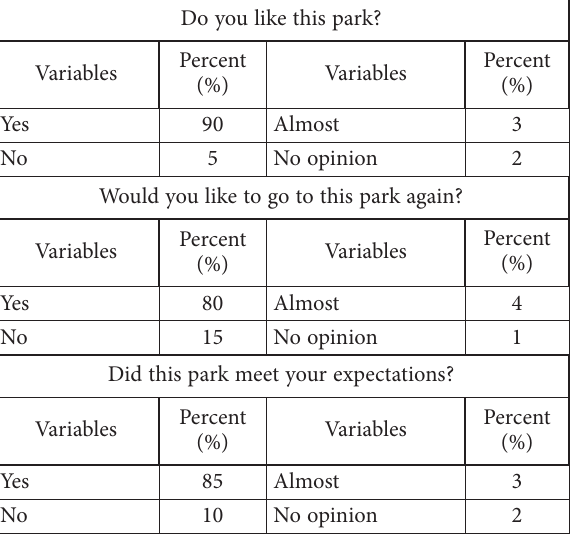
Table 9. General satisfaction of users